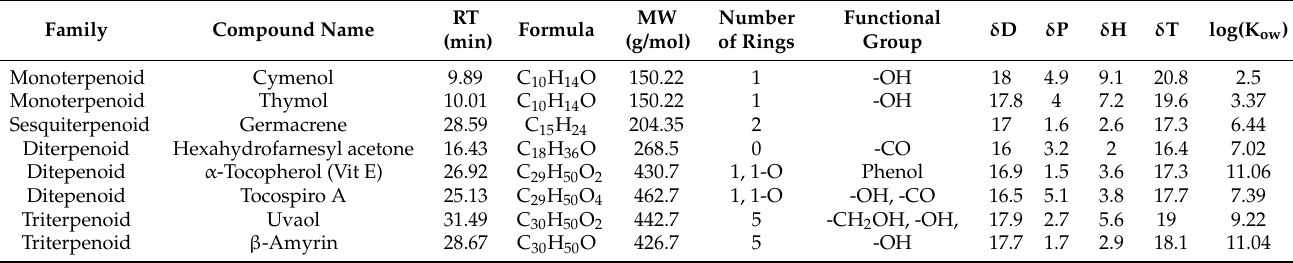
Table 2. Representative terpenoids identified by GC-QTOF-MS from olive leaves extract obtained by scCO 2 , showing their molecular formula, molecular weight, number of rings, main functional groups in the molecule, Hansen Solubility Parameters (HSPs: contributions for dispersion ( δ D), polar ( δ P), hydrogen bond ( δ H), and total ( δ T)) and octanol–water partition coefficient (log(K ow